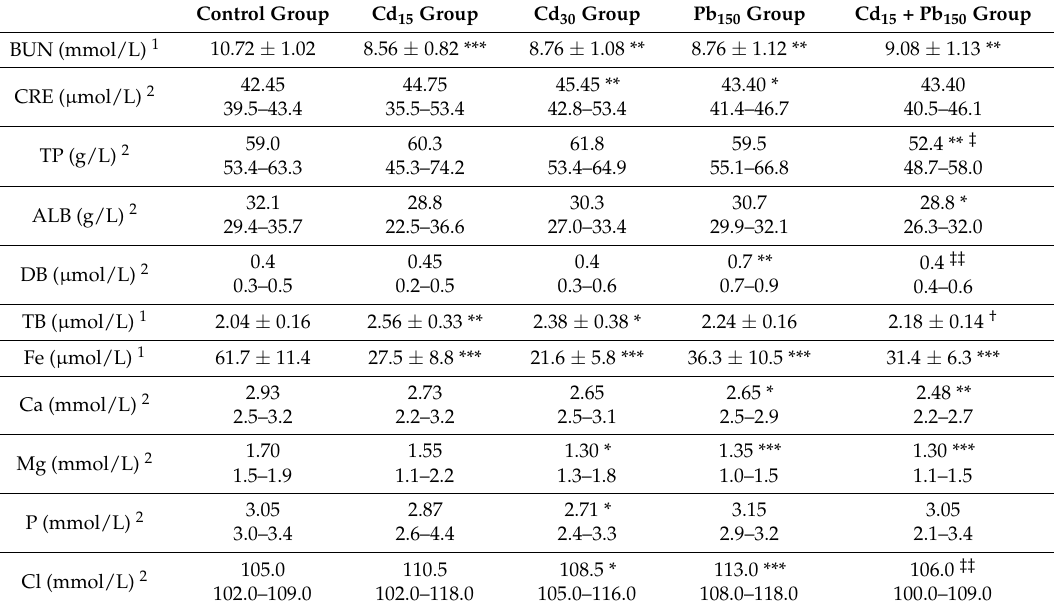
Table 2. Effect of Cd or/and Pb on biochemical parameters in rat serum after acute